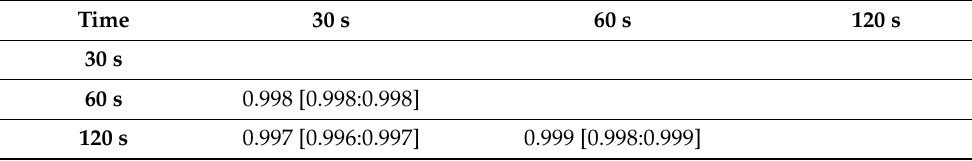
Table 4. Intrasystem correlation between rPPGc as a function of time. Time 30